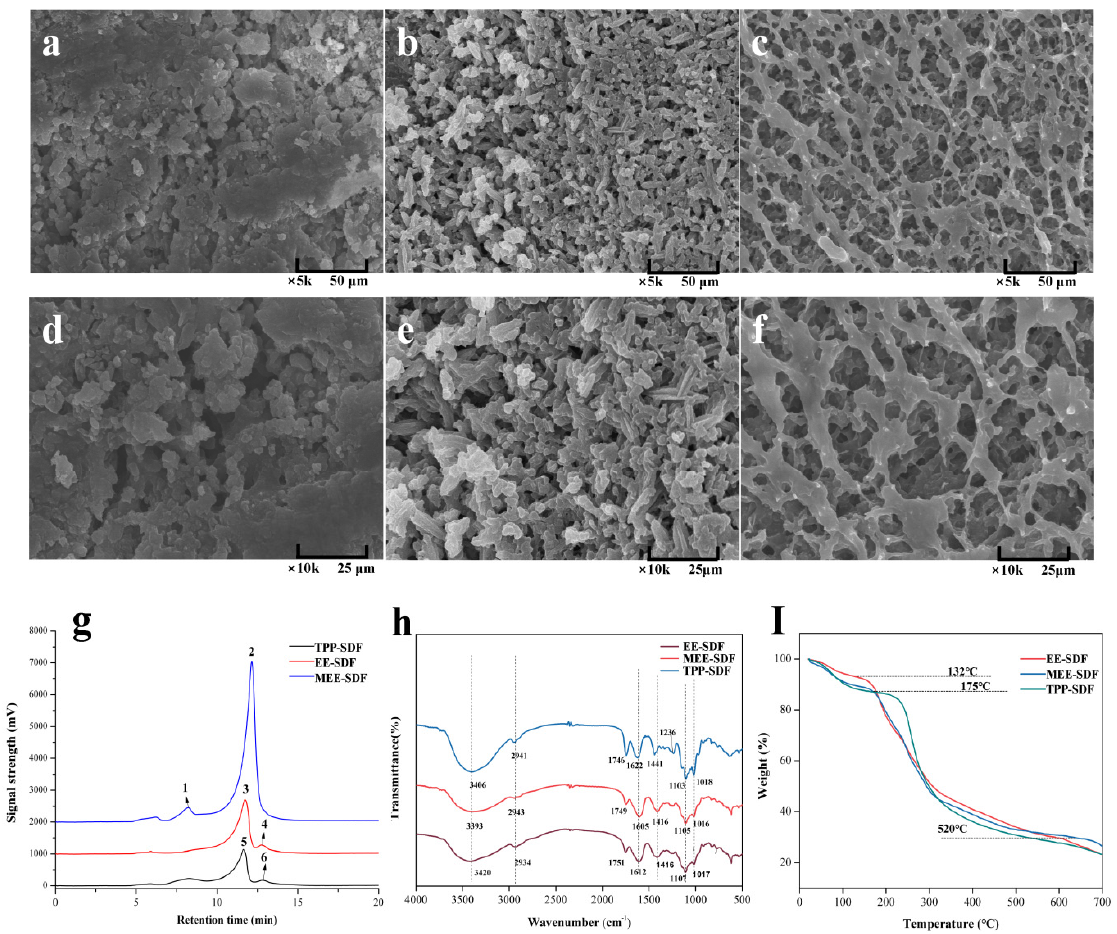
Figure 2. Structural characteristics of SDFs prepared with different extraction methods. SEM of EE-SDF × 5 k ( a ); MEE-SDF × 5 k ( b ); TPP-SDF × 5 k ( c ); EE-SDF × 10 k ( d ); MEE-SDF ×10 k ( e ); TPP-SDF ×10 k ( f ); molecular weight distribution ( g ); FT-IR spectra of SDFs ( h ); TGA curves of SDFs ( I ).